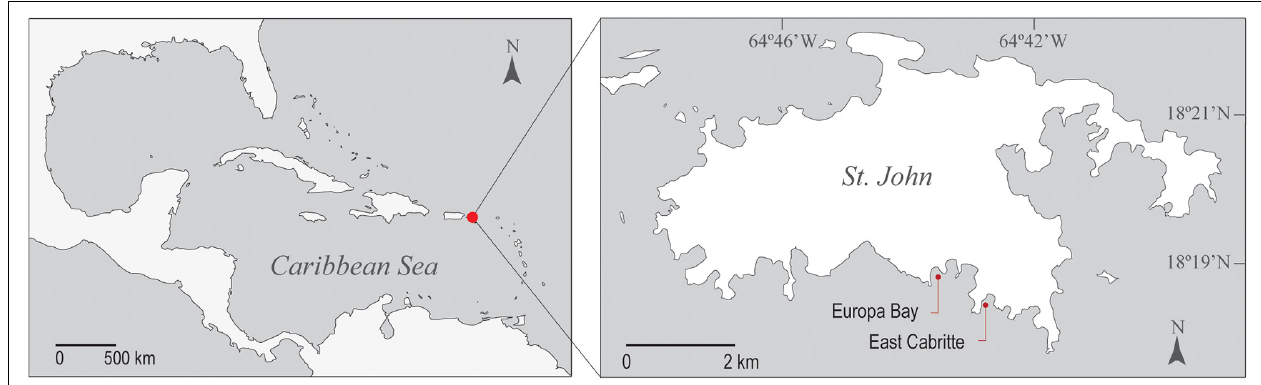
FIGURE 1 | Map of study area in the Caribbean Sea, showing the study sites along the south shore of St John, United States Virgin Islands, Europa Bay (18 ◦ 19.003N; 064 ◦ 43.796W), and East Cabritte (18 ◦ 18.551N; 064 ◦ 43.129W).